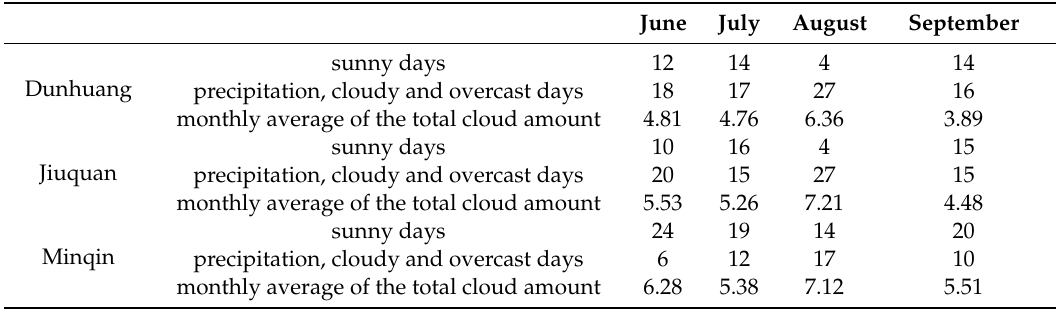
Figure 6. Variation in the monthly average of maximum height differences four times per day (Unit: m). Table 3. Statistics of days of di ff erent weather and total cloud cover (Unit: 1) in the three areas from June to September